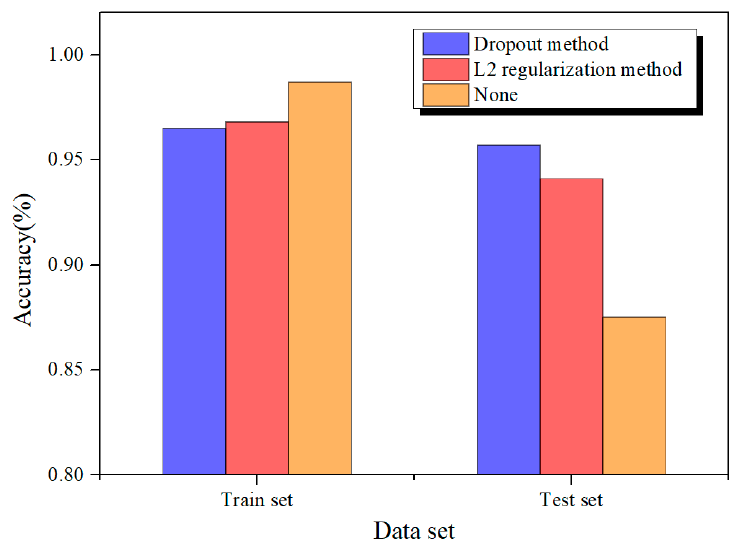
Figure 10. Comparison results of CNN on training set and validation set under different Comparison results of CNN on training set and validation set under di ff erent regularization regularization techniques.